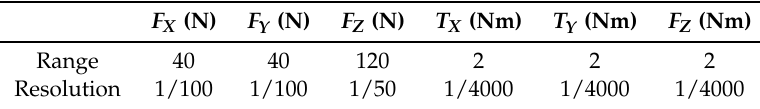
Table 2. Test Matrix for the force based